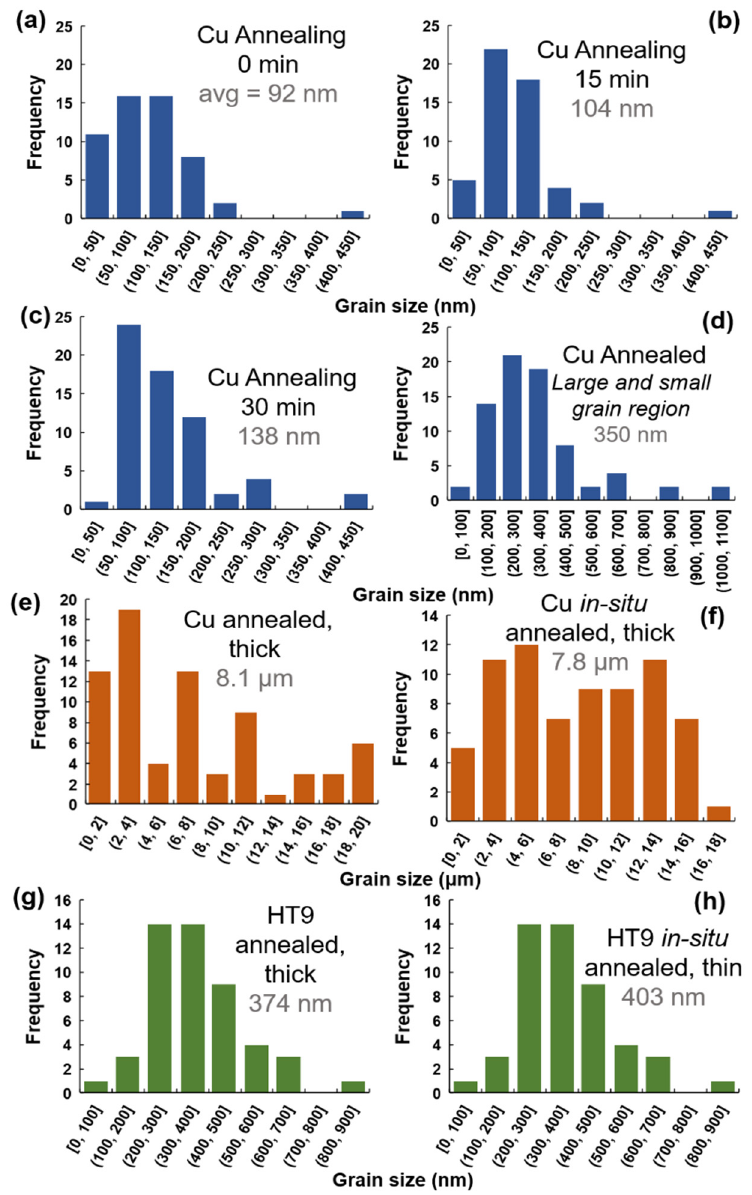
Figure 3. Grain size histograms for ( a – d ) in-situ Cu annealing as shown in Figure 2, with ( d ) showing grain size after annealing in a larger area of the thin area in the sample. ( e , f ) show Cu annealed corresponding to the EBSD ( c , d ) in Figure 2 respectively. ( g , h ) HT9 annealed corresponding to ( e , f ) in Figure 2 respectively.